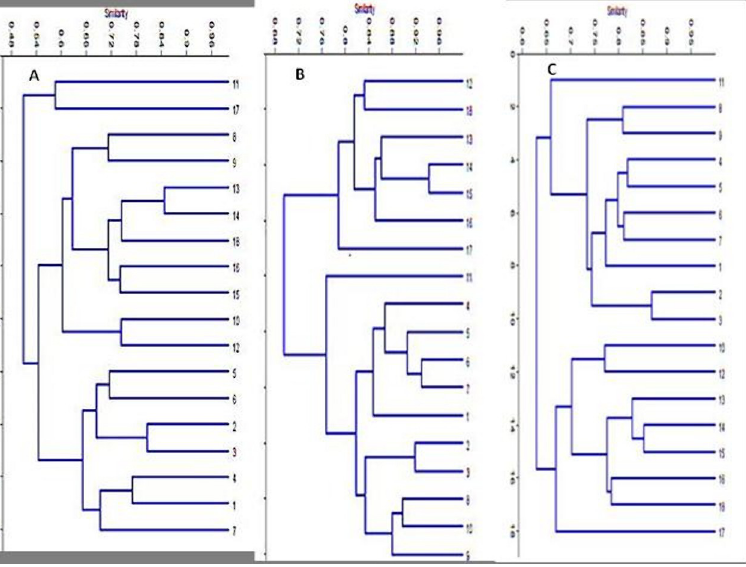
Fig 5. A dendrogram based on UPGMA analysis using. (A) SCoT marker, (B) SRAP, (C) Combined data among 18 wheat genotypes.